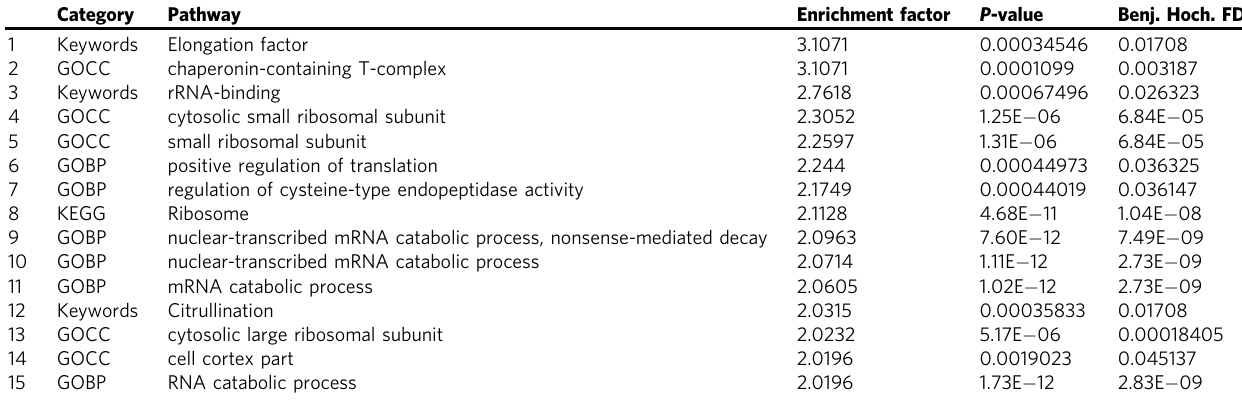
Table 1 Pathway analysis of the co-downregulated proteins (n = 413) at + 24 and + 48 h in Nalm-6 cells cocultured with 3T3-L1 adipocytes, as detected by pulsed SILAC. Pathway enrichment was assessed by two-sided Fisher ’ s exact tests with a Benjamini – Hochberg FDR of 5%. Pathways with an enrichment >2 are